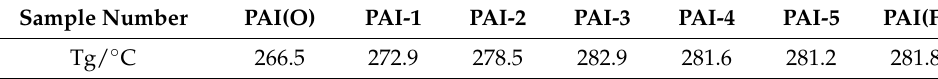
Figure 3. DSC curve of synthetic PAI materials. Table 2. Glass transition temperature of synthesized PAI